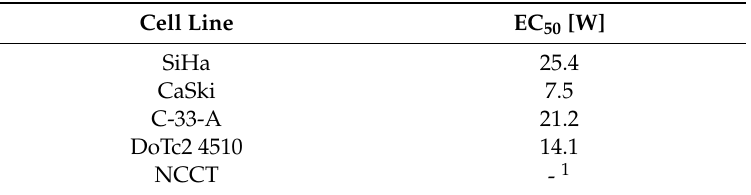
Figure 2. Non-cancerous cervical tissue (NCCT) cells are less sensitive to MABS compared to cervical cancer (CC) cells. Relative survival plots of CC cells (SiHa, Ca Ski, C ‐ 33 A, DoTc 2) or NCCT cells fixed six days after MABS treatment with increasing watt power for ( a ) 5 s, ( b ) 10 s, and ( c ) 20 s. Shown is the average of three independent experiments. For better visibility, the standard deviations are excluded from this graph (see Figure S3 for full data set). In the bar diagrams (lower part), the values for 40 W and 5 s ( a ), 10 s ( b ), and 20 s ( c ) are plotted. Results are expressed as the mean ± SD of relative survival. * p < 0.05, ** p < 0.01, *** p < 0.001 as determined by Student’s t ‐ test. Table 1. ED 50 doses (in Watt) necessary to cause 50% of overall cellular response of non ‐ thermal MABS treatment for 10 s.